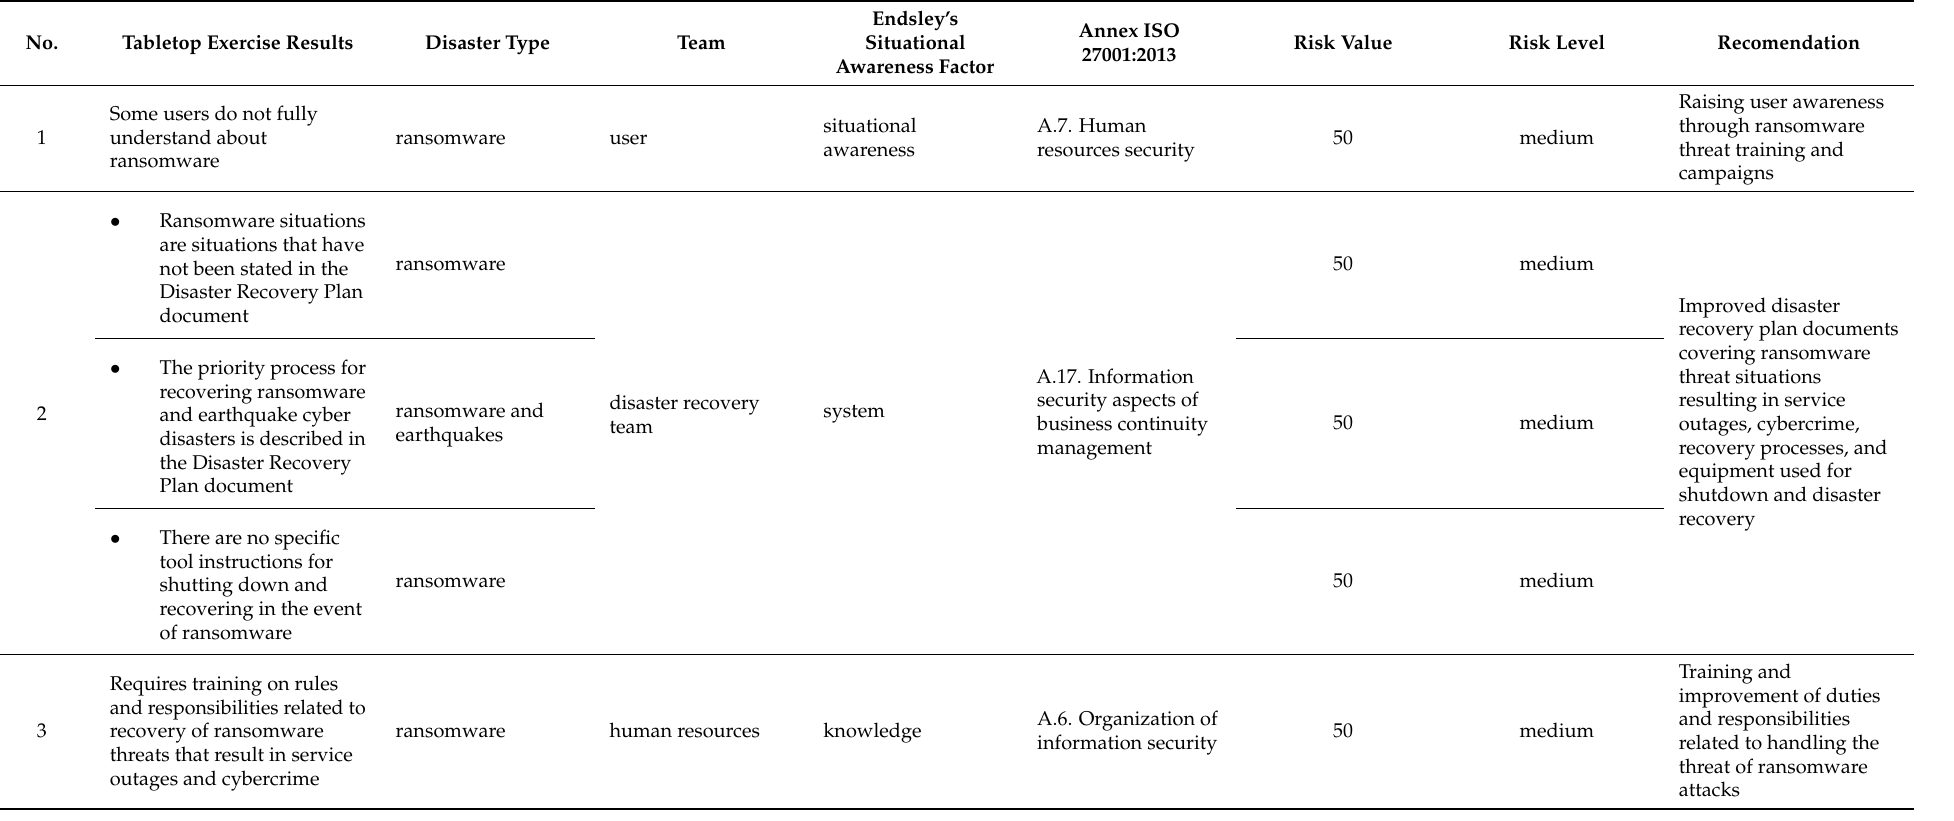
Table A3. Risk Value of Network Security Tabletop Exercise Findings Based on Annex ISO